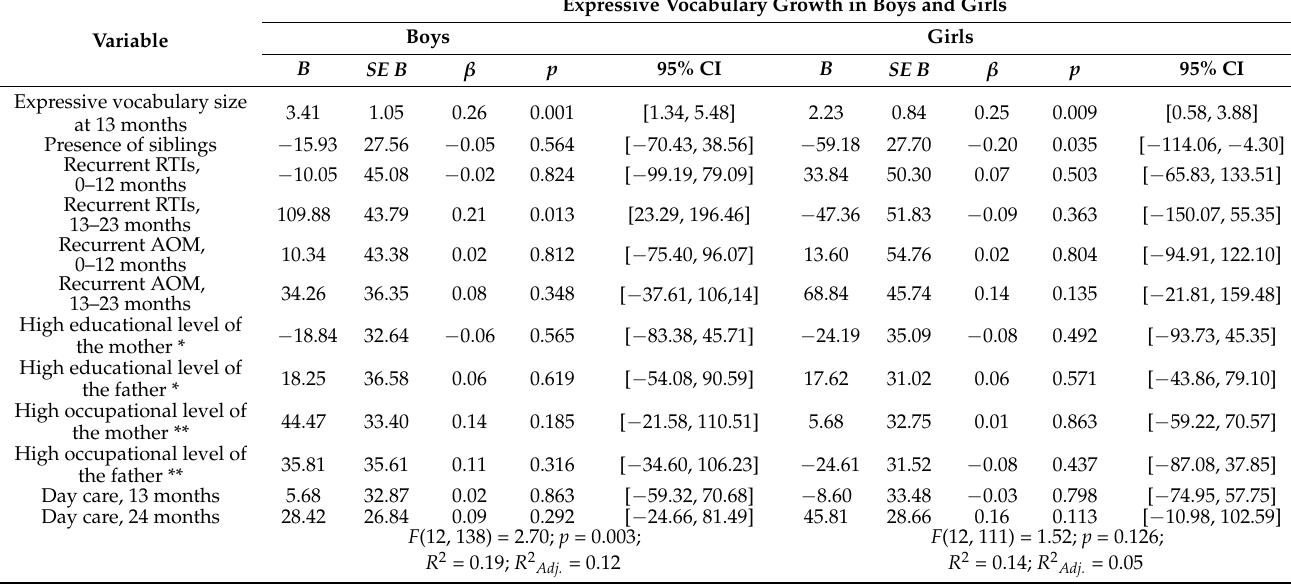
Table 3. Effects of risk and background factors on vocabulary growth separately in boys and girls between 13 and 24 months of age, as calculated with a linear regression